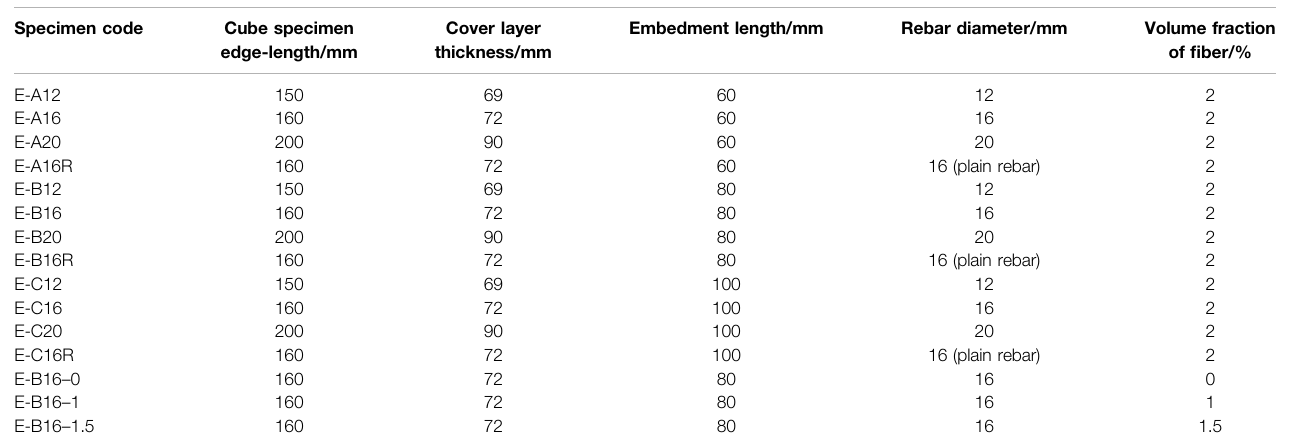
TABLE 4 | Detailed parameters of pull-out test specimens. Specimen